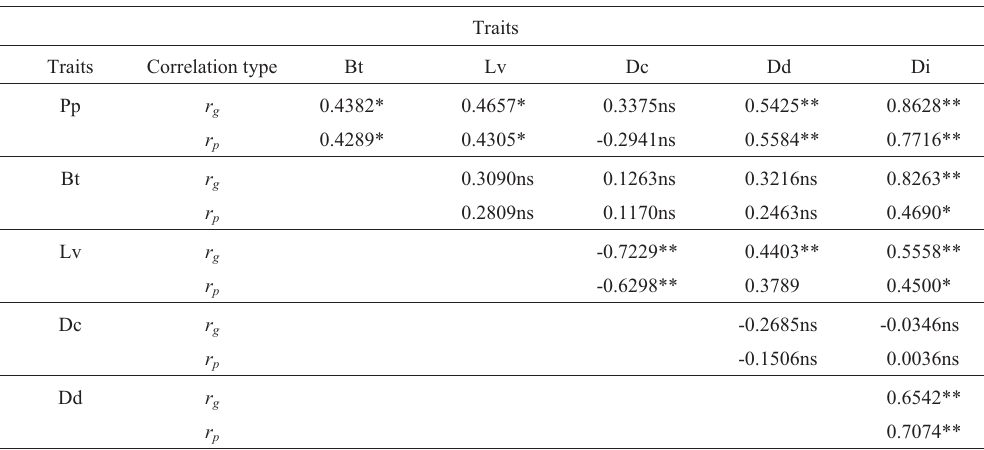
Table 5 - Genotypic ( r g ) and phenotypic correlations ( r p ) for bark thickness (Bt), total number of latex vessel rings (Lv), average distance (mm) between consecutive latex vessel rings (Dc), density of latex vessels per 5mm per ring (Dd) and diameter of latex vessels (Di) in 22 three-year-old open-pollinated Hevea progenies growing at three sites in the Brazilian state of São Paulo. Values represent means for the three